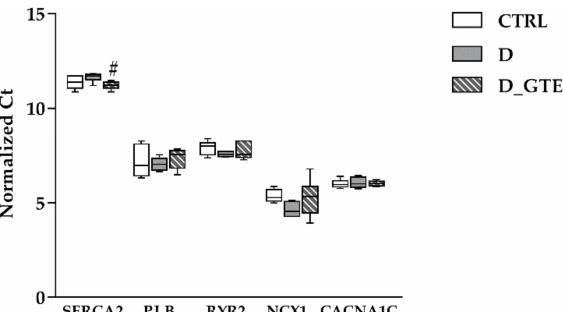
Figure 4. Box plot distribution of the normalized CTRL, D and D_GTE Ct values of SERCA2, PLB, RYR2, NCX1 and CACNA1C. The Ct value of the reference gene was normalized over the Ct value of GAPDH. Normalized Ct values: higher values correspond to lower gene expression levels; # p < 0.05 significant differences vs. D (Kruskal–Wallis test).